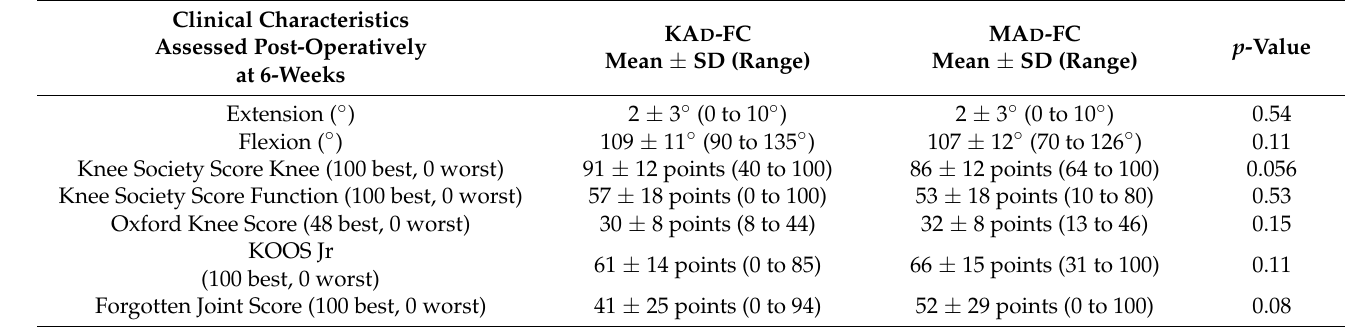
Table 3. Compares range of motion and clinical outcomes scores and complications at 6 weeks post-operative between paired knees treated with KA and a KA D -and MA D -FC.